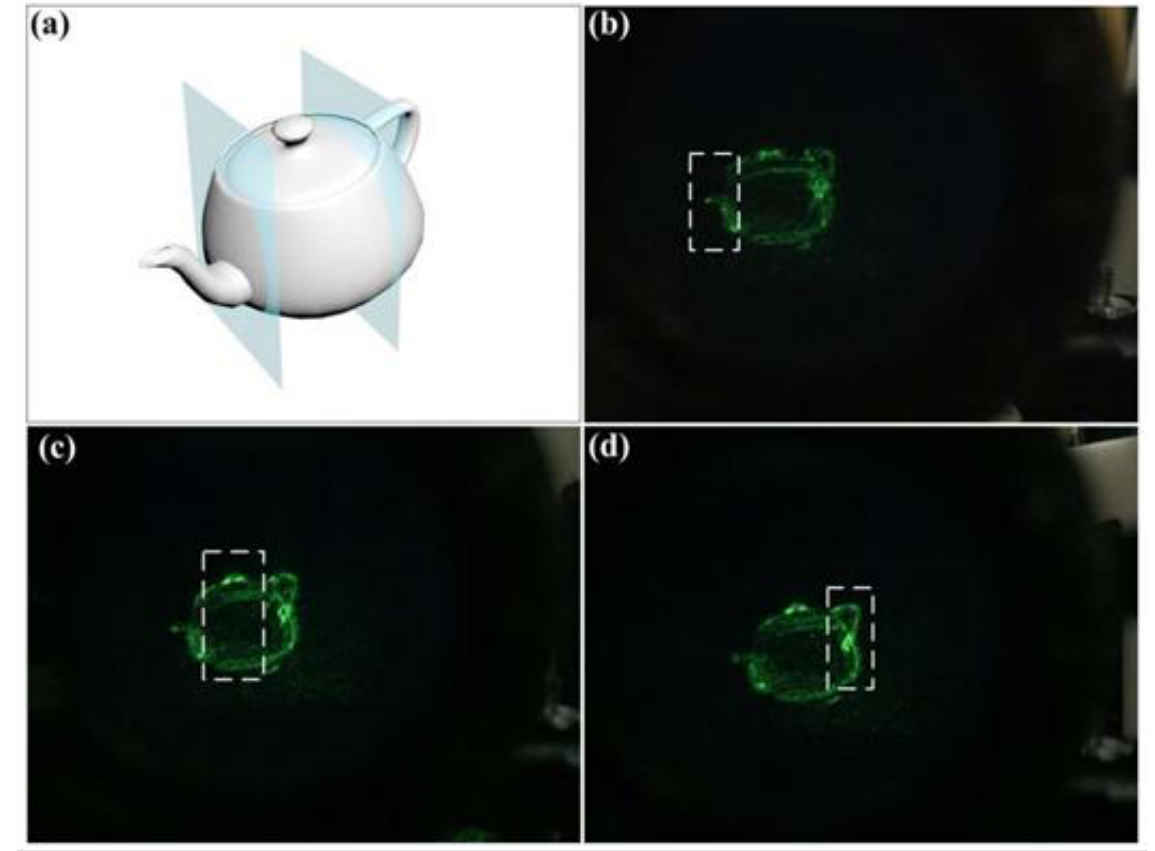
Figure 8. Experimental results of 3D near-eye display of “teapot”. ( a ) The sliced 3D model “teapot”. ( b – d ) The reconstruction focused on the spout, lid and handle, respectively.